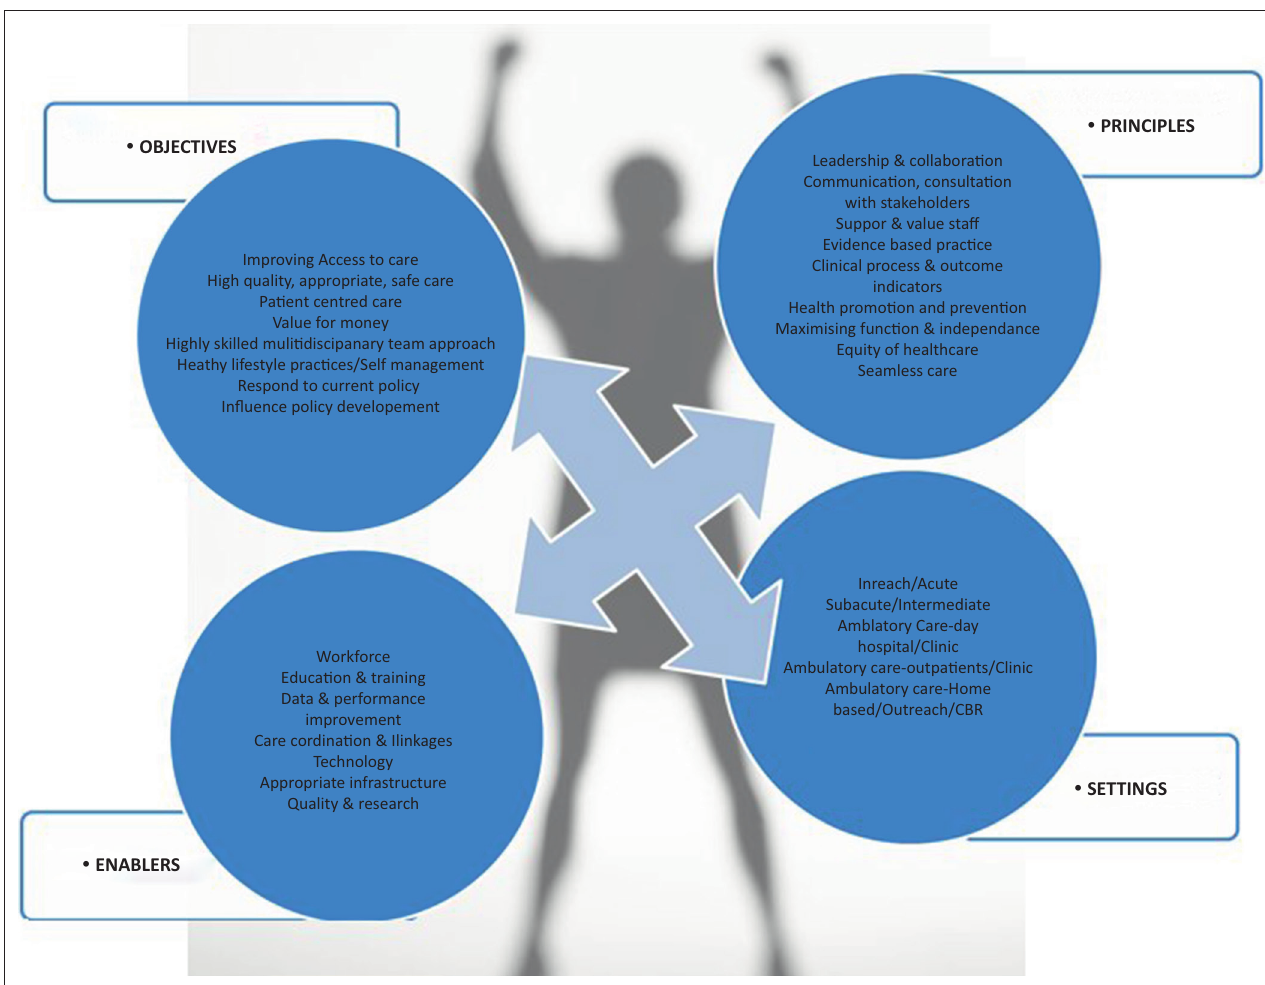
FIGURE 1: A synthesis of Australian models of care in